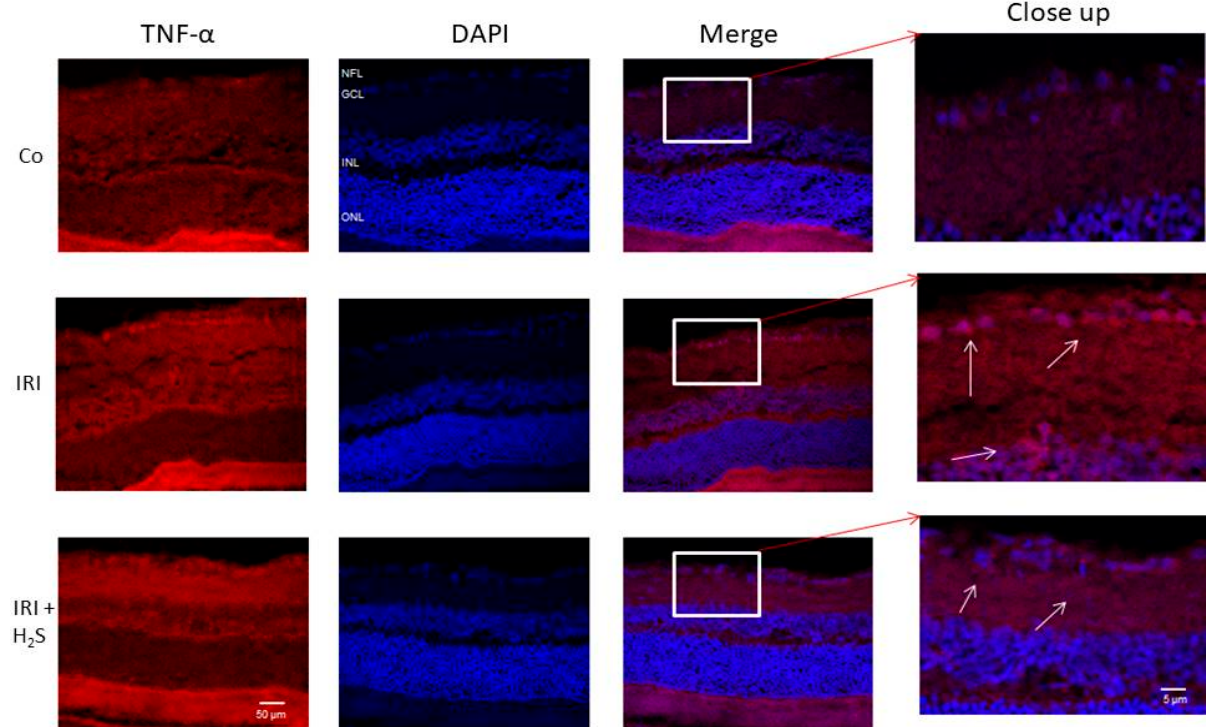
Figure 6. TNF- α expression after unilateral IRI and H 2 S inhalation. Double staining was performed to clarify in which areas of the retina the expression of TNF- α occurs. Cross-sections of the retinae 7 days after unilateral IRI showed that IRI led to an increased expression of TNF- α mainly in the retinal ganglion cell layer, as well as in the inner nuclear layer. After the application of H 2 S, the expression was attenuated. Abbreviations: NFL = nerve fiber layer; GCL = ganglion cell layer; INL = inner nuclear layer; ONL = outer nuclear layer.